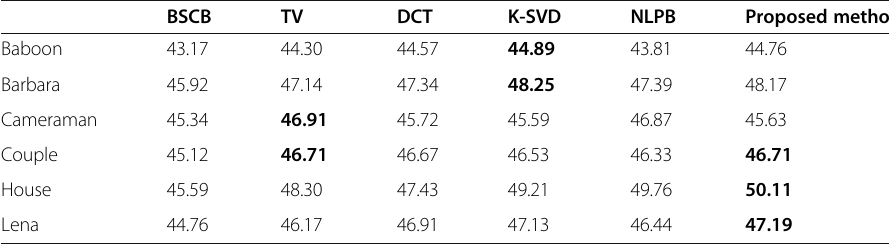
Table 1 The PSNR of each method for removing text coverage (Unit: dB) BSCB